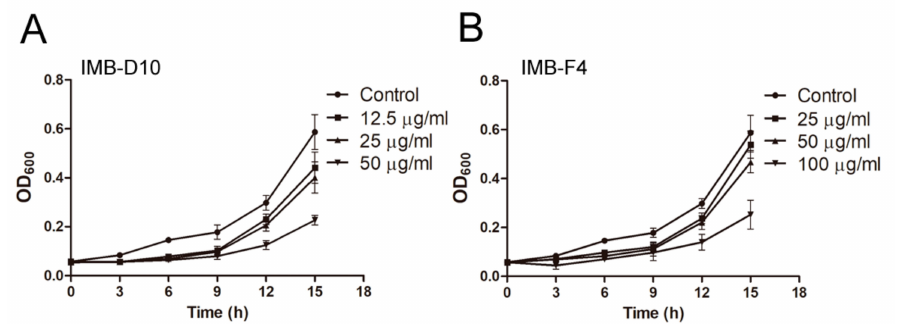
Figure 2. Dose-dependent growth inhibition of WT yeast cells (BY4741) by compounds IMB-D10 ( A ) and IMB-F4 ( B ). Compounds were added into cell cultures to the final concentrations as indicated, and OD 600 was measured over time. All experiments were performed in triplicate. All cell cultures contained the same concentration of DMSO (0.25%). Data are presented as mean ±